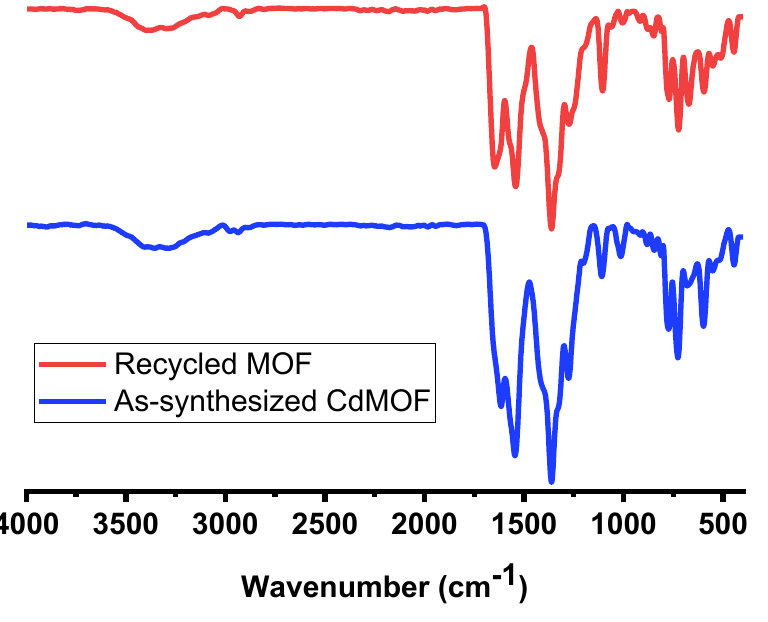
Figure 13. Infra-red spectra of the as − synthesized and recycled CdMOF after three catalytic cycles.